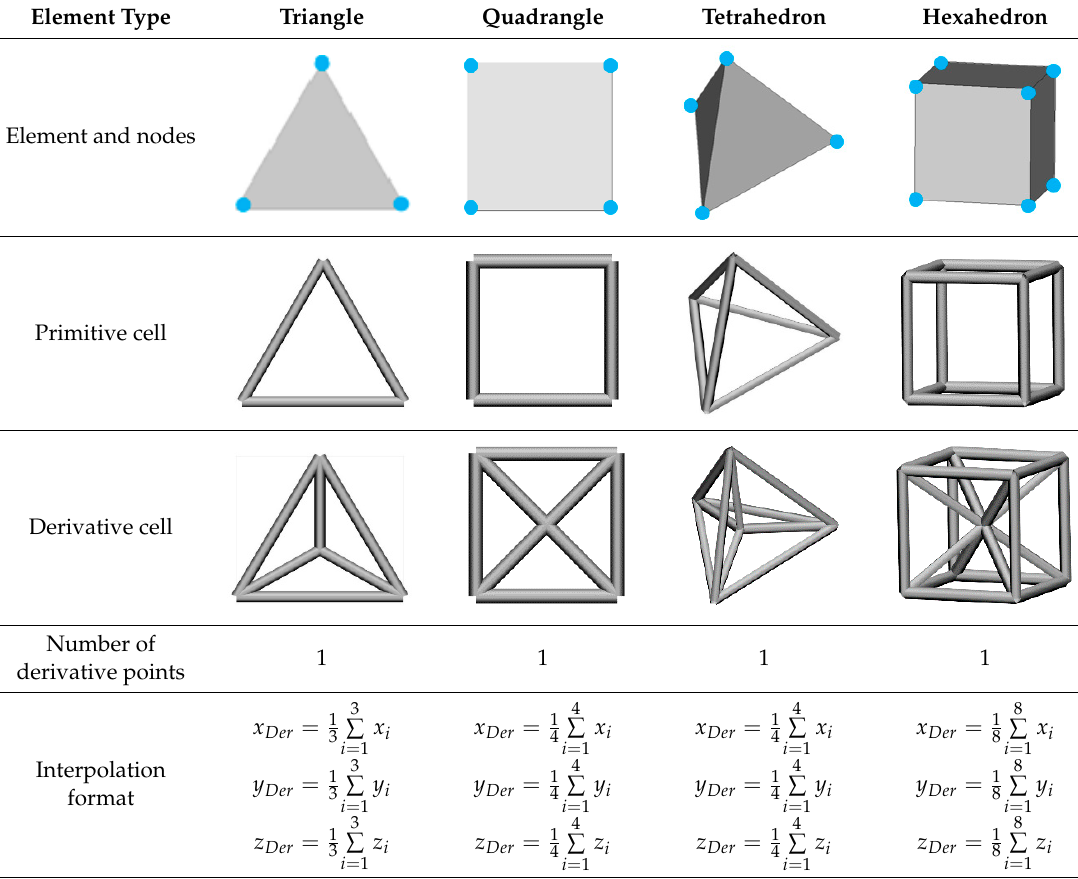
Table 1. Illustrations of elements, primitive cells, derivative cells and interpolation formats.